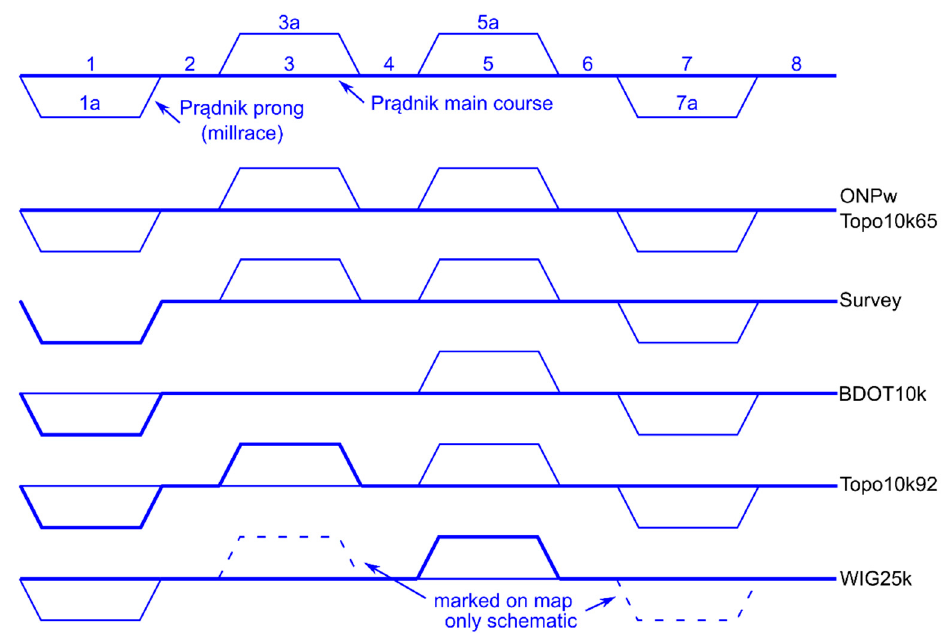
Figure 12. Comparison of main and lateral watercourse (parts − 1 to 8) distinction in data sources. Table 5. Total sinuosity for the vector data sources and topographic